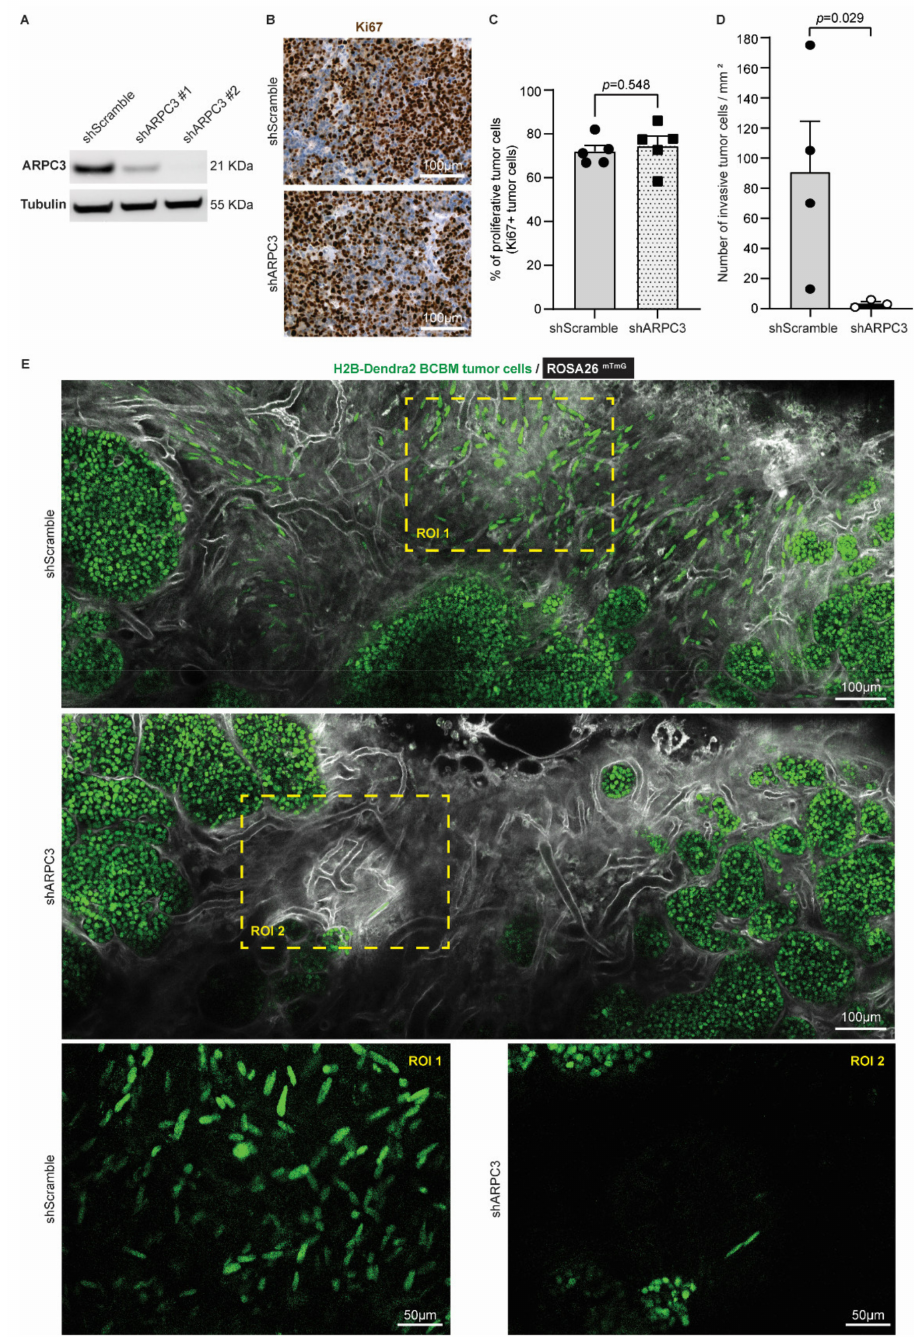
Figure 3. Reducing ARPC3 expression decreases the number of invasive tumor cells. ( A ) Western- blot of ARPC3 and Tubulin on BCBM tumor cells engineered with the shScramble or shARPC3 constructs. See Figure S1 for uncropped blot. ( B ) Representative images and ( C ) quantification of Ki67 immunohistochemistry staining in BCBM derived from shScramble or shARPC3 organoids intracranially injected into recipient mice. Data are presented as mean +/ − standard-error of the mean (SEM); n = 5 mice per group; p -value was determined using a Mann–Whitney t -test, two- tailed. ( D ) Quantification of the number of invasive tumor cells observed by intravital imaging of ROSA26 mTmG mice injected with shScramble or shARPC3 BCBM organoids. Data are presented as mean +/ − SEM; n = 4 mice for shScramble and n = 3 mice for shARPC3 #2; p -value was determined using a Mann–Whitney t -test, one-tailed. ( E ) Representative multi-photon images of BCBM derived from shScramble and shARPC3 BCBM organoids intracranially injected into ROSA26 mTmG